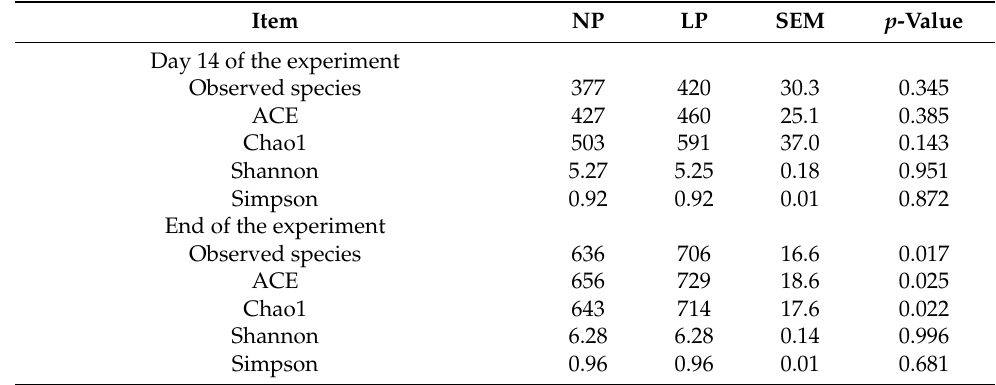
Table 5. Effects of protein restriction and realimentation on the alpha-diversity of colonic microbiota of piglets 1